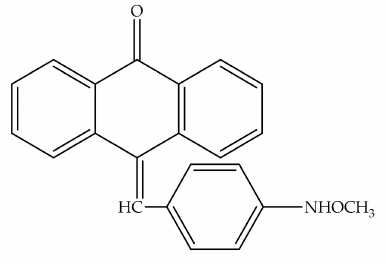
Figure 8. Chemical structure of